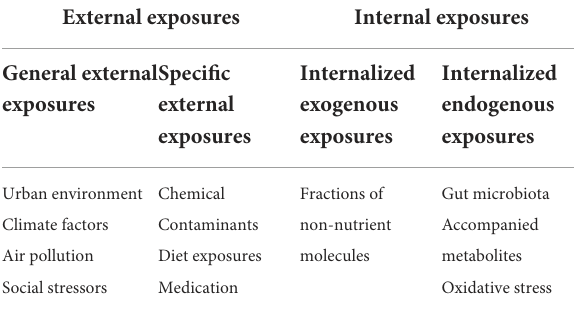
TABLE 1 Types of exposomes external and internal